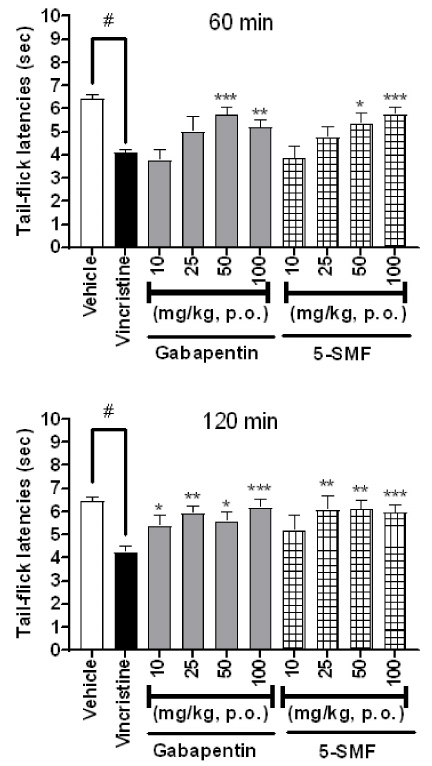
Figure 16. Effect of 5-SMF and gabapentin in the vincristine-induced pain model at 60 and 120 min. Data are expressed as mean ± SD; n = 7 mice per group. ( # p < 0.001 vs. vehicle group, * p < 0.05, ** p < 0.01 and *** p < 0.001 vs. vincristine